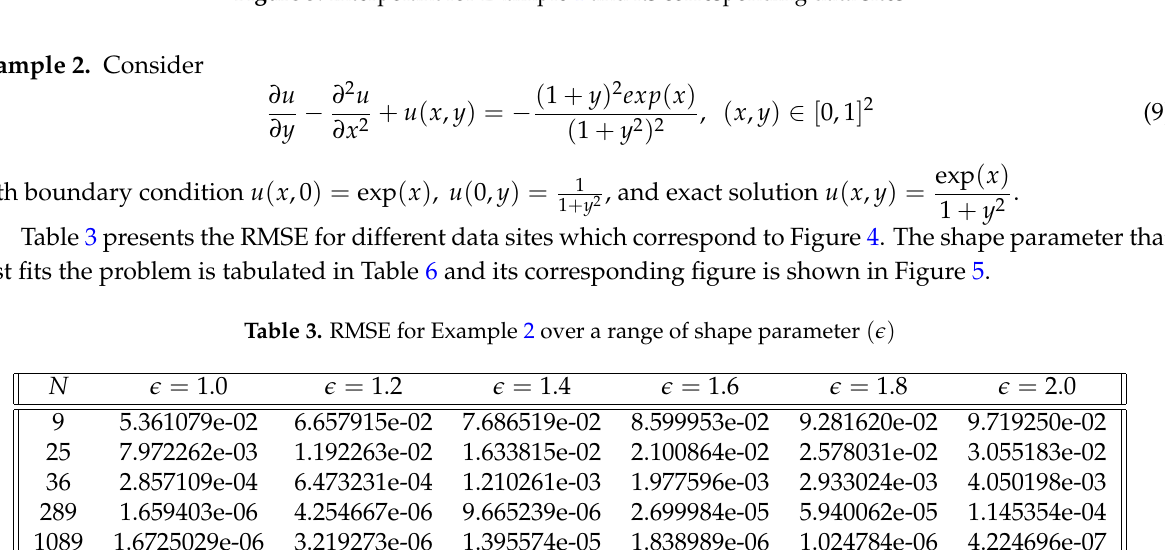
Figure 3. Interpolant for Example 1 and its corresponding data sites